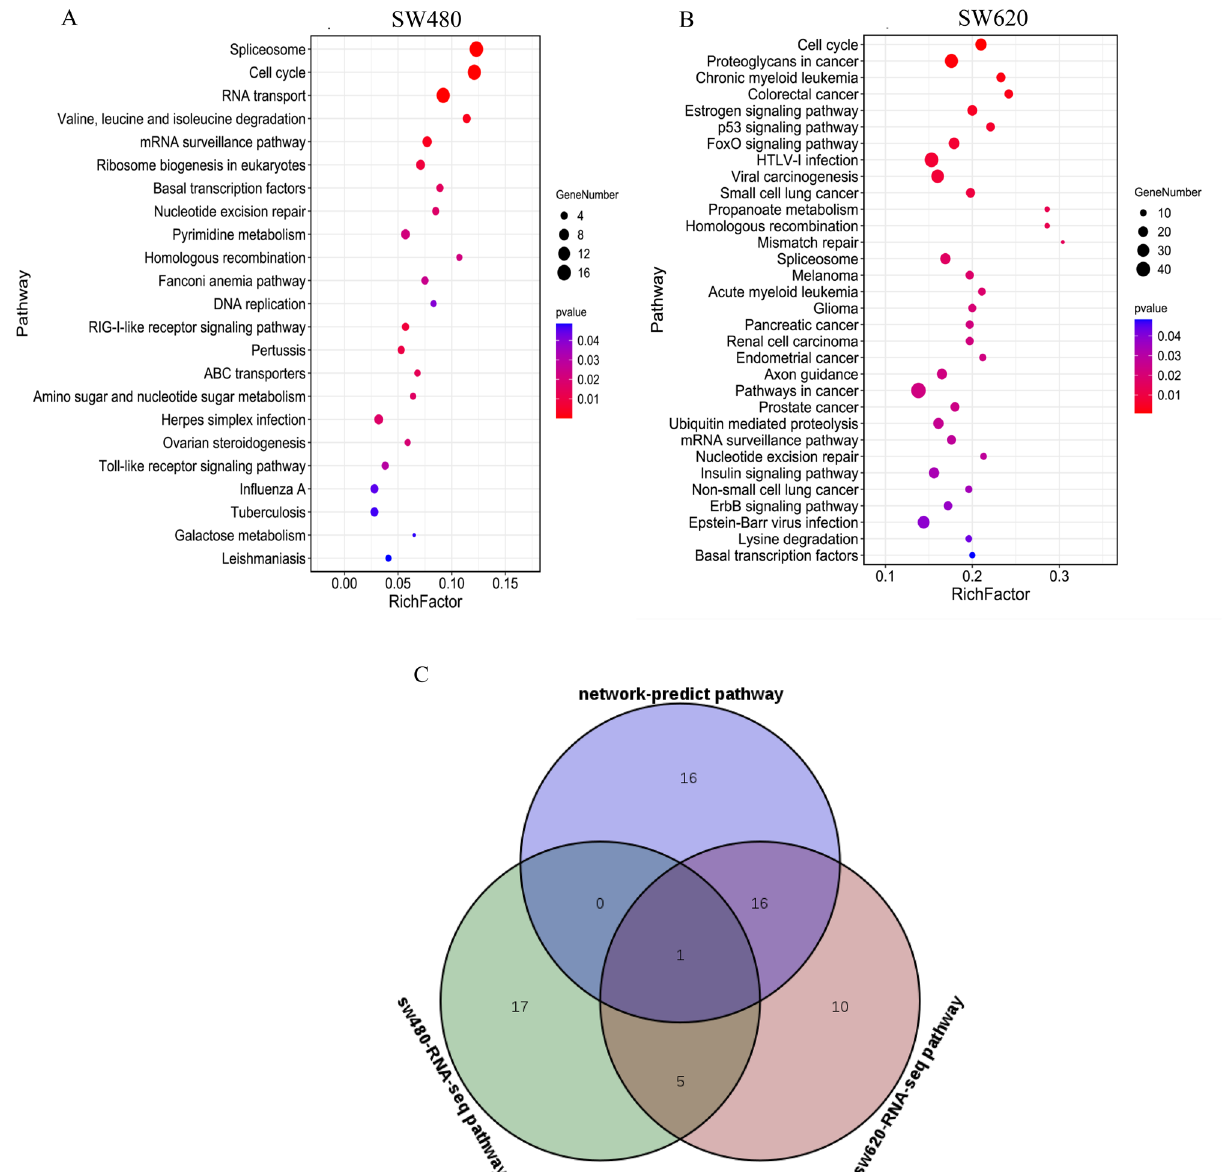
Figure 4. Functional analysis of CKI against SW480 and SW620 cells based on RNA-seq data. ( A ) Kyoto Encyclopedia of Genes and Genomes (KEGG) pathways related to CKI against SW480 cells. ( B ) KEGG pathways related to CKI against SW620 cells. ( C ) Venn diagram of pathways that were enriched based on RNA- Seq data and predicted by network pharmacology. The image was created using the OmicShare tools, a free online platform for data